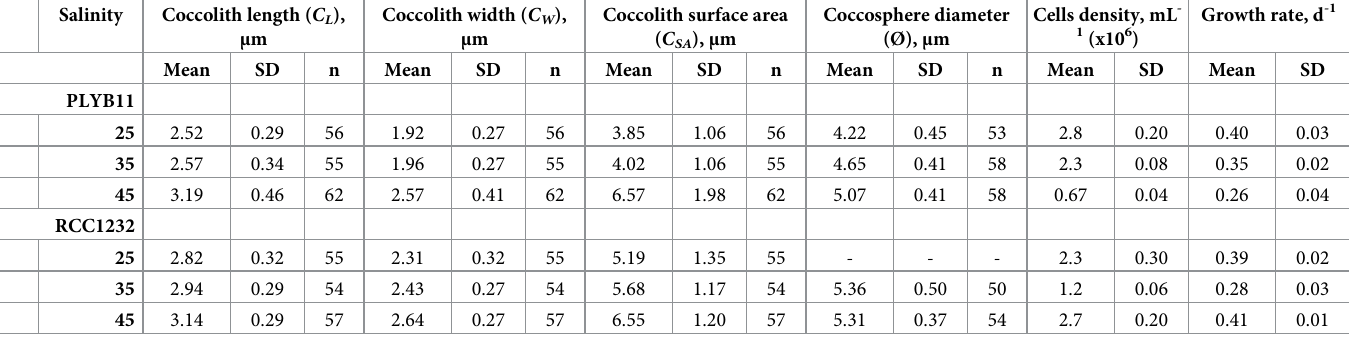
SD = standard deviation, n = number of individual coccoliths or coccospheres